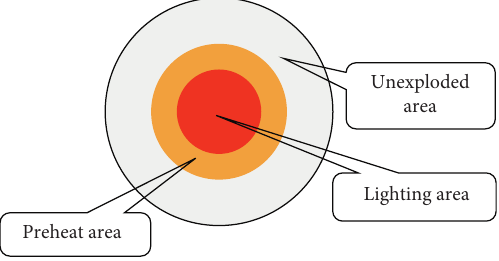
Figure 8: Minimum flame